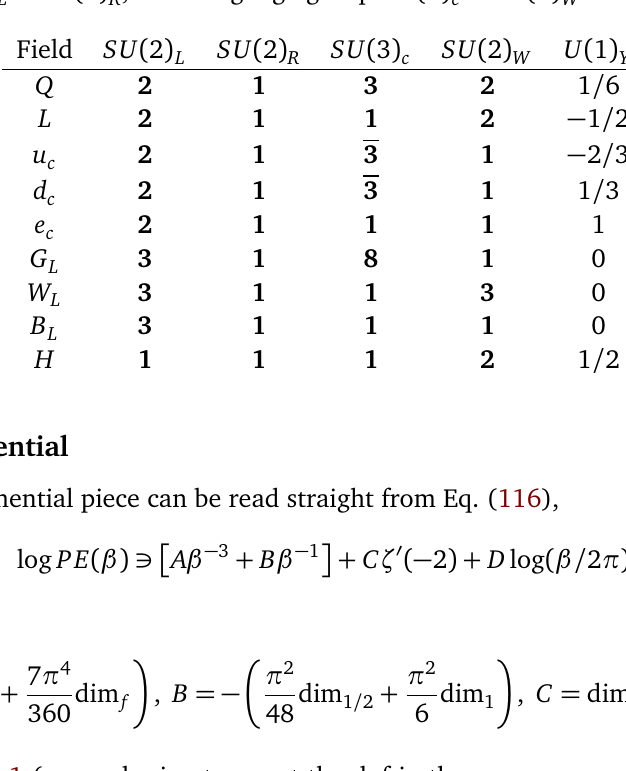
× SU ( 2 ) × U ( 1 ) of the c W Y